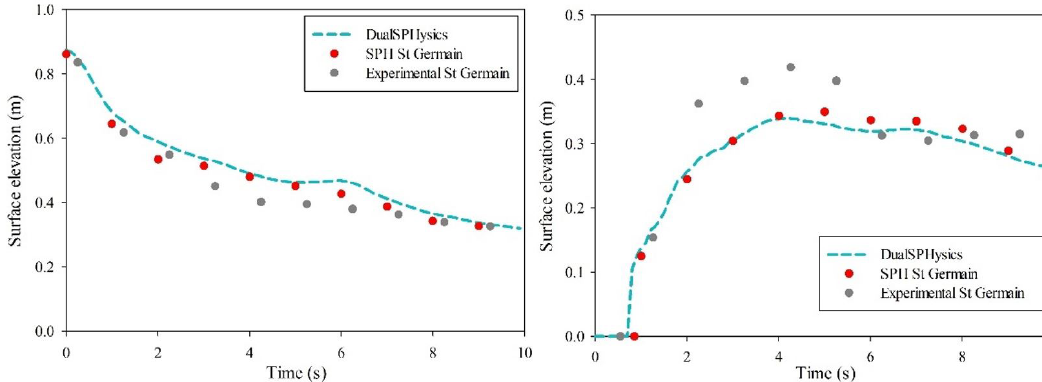
Nat. Hazards Earth Syst. Sci., 22, 2589–2609, 2022